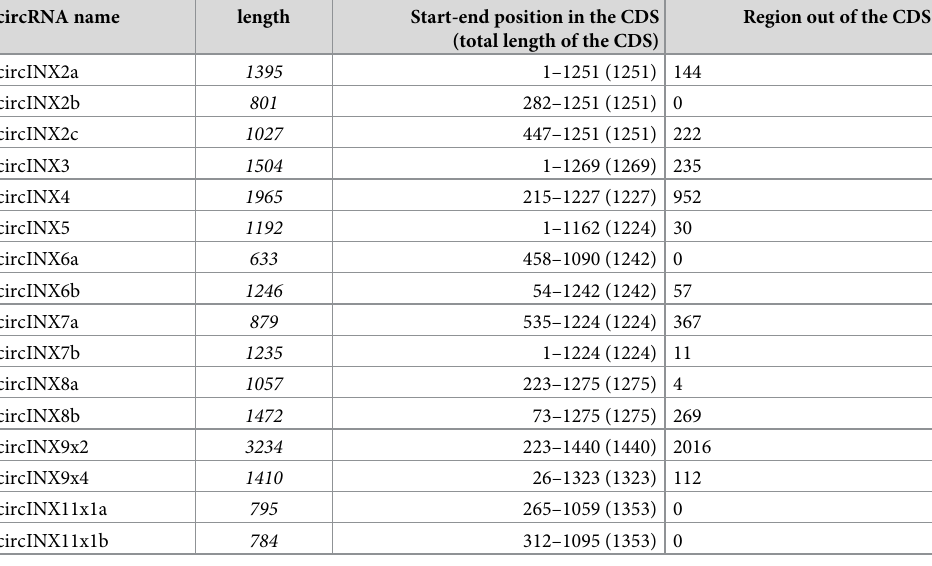
Table 1. Summary of identified Limax innexin circular RNAs (circRNAs) in the central nervous